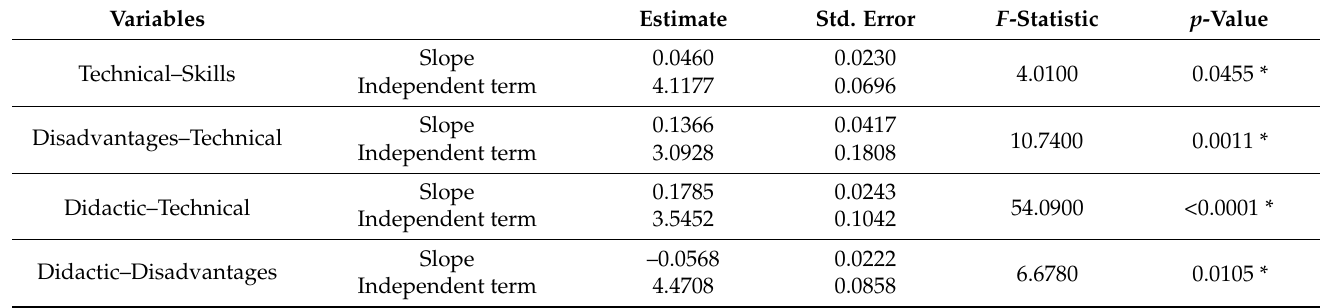
Table 4. Statistics of the linear regression model of the different pairs of factors of the questionnaire with statistically significant Pearson correlation